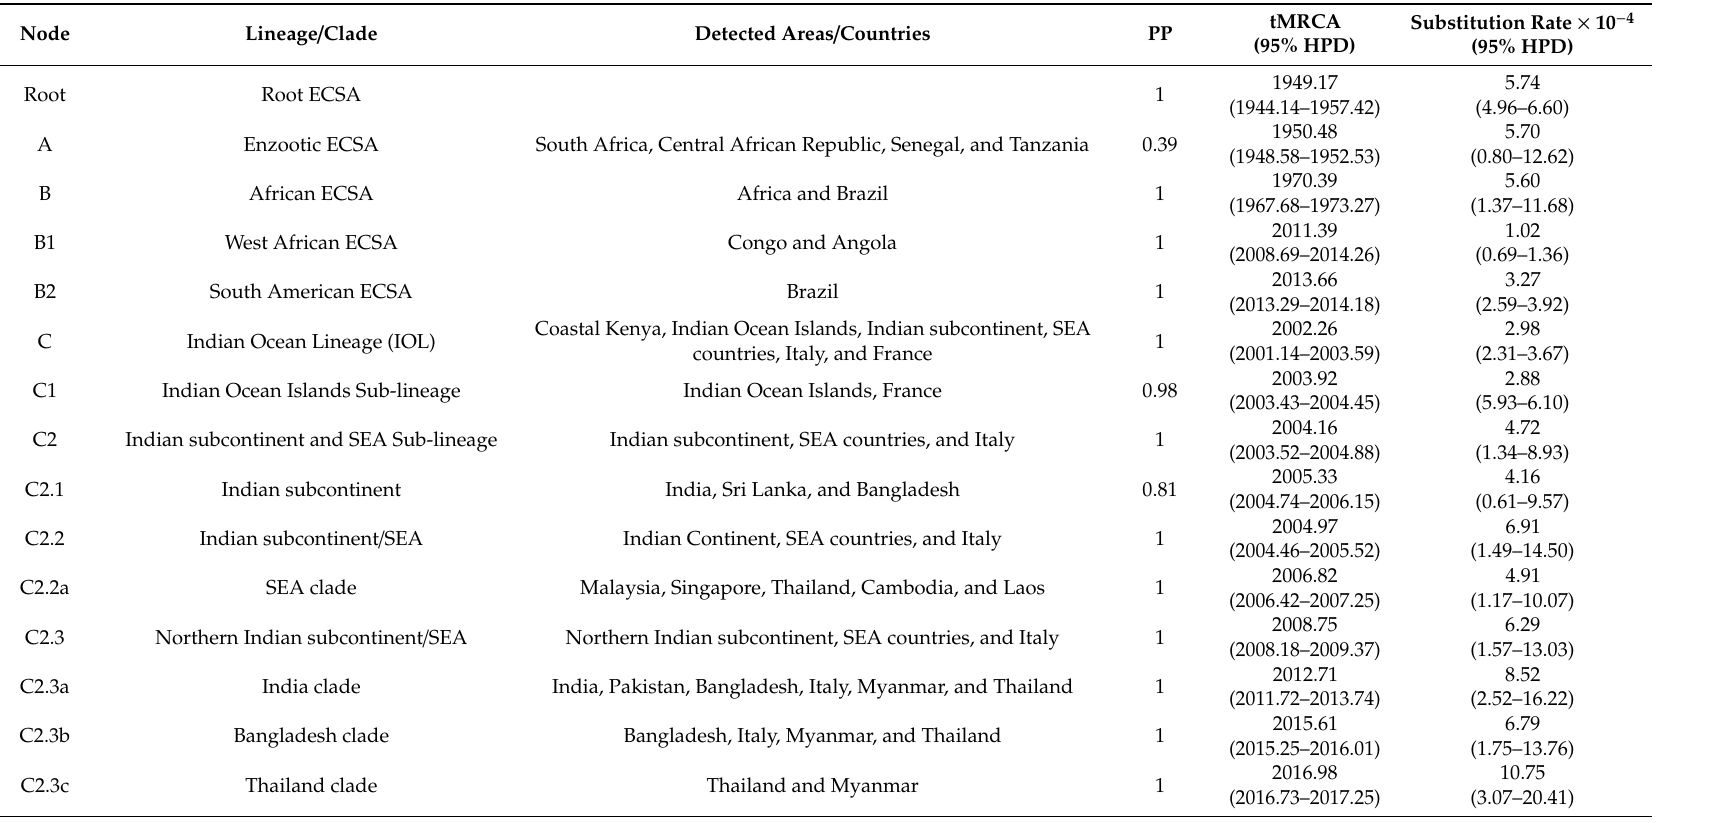
Table 2. tMRCA and evolution rates of ECSA-IOL CHIKV